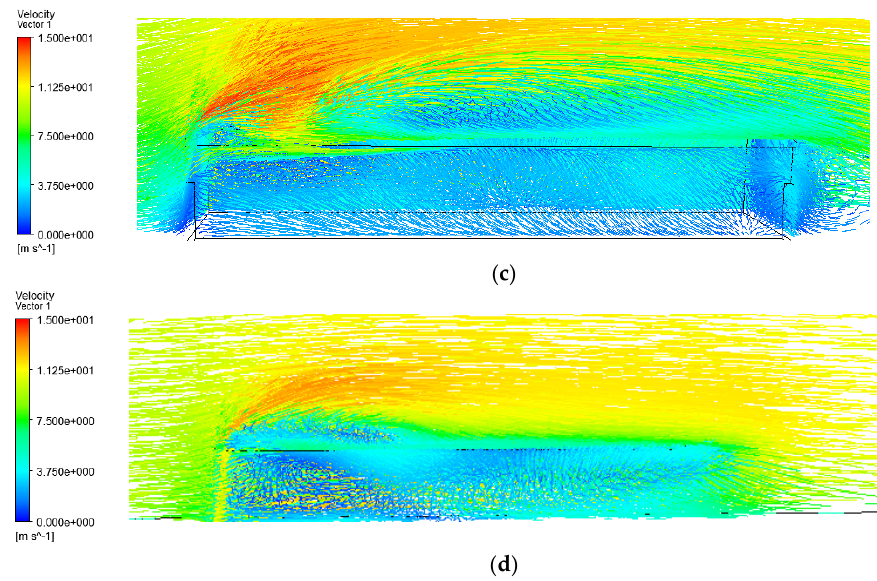
Figure 11. Wind velocities at 0.5 m to the walls of the building: ( a ) south wall in the north wind, ( b ) north wall in the north wind, ( c ) south wall in the west wind, and ( d ) north wall in the west wind.